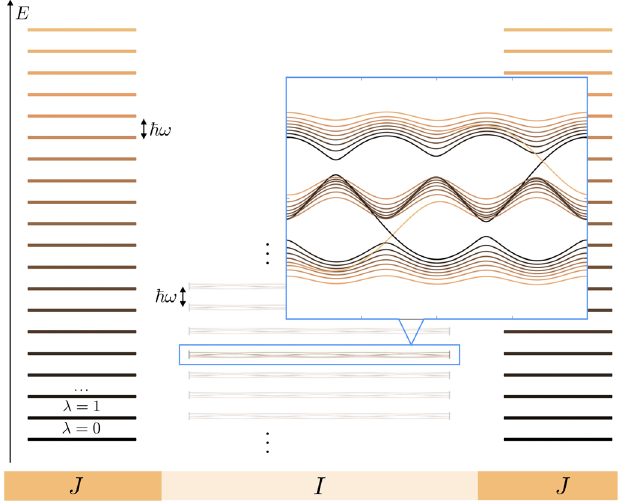
FIG. 10. Schematic representation of the energy levels of the junction regions ( J ) and the inner region ( I ). The color scale is chosen as in Fig. 7(a) and indicates the mean position h λ i of the states. The levels in the junction region are the harmonic oscillator states separated by λω . The quasienergy spectrum ε ð k y Þ of the inner region contains contributions from all the λ states due to the coupling provided by the shaking. Here the Floquet spectrum is represented in an extended zone scheme, according to which the same Floquet eigenstates are repeated periodically, E ¼ ε þ n ω . We note that the separation between these Floquet multiplicities matches the separation between the bare λ states. The dispersion of the states in the junction due to propagation along the y direction is associated with a small bandwidth J y ≪ ℏ ω , which is of the same order as the bandwidth of the quasienergy spectrum in the channel. The population of the Floquet eigenstates within the channel is nonthermal but reflects the thermal population in the undriven reservoirs (see